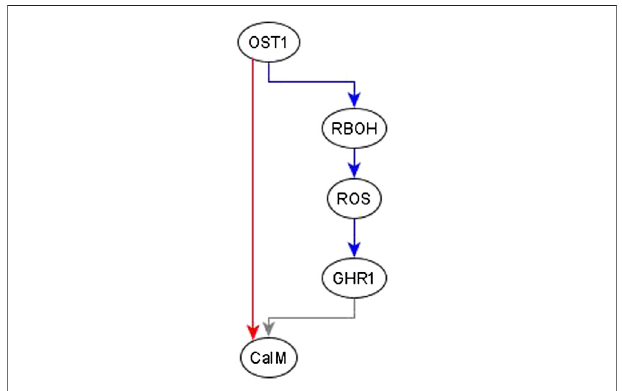
FIGURE 6 | Addition of suf fi cient edge from OST1 to CaIM to re fl ect the causal logic inferred from the literature. The suf fi cient regulatory relationship of OST1andCaIMisnotre fl ectedinthepathgivenbyOST1 → RBOH → ROS → GHR1 → CaIM.Thepath fromOST1toGHR1 isnecessarybut theedge fromGHR1toCaIMisneithersuf fi cientnornecessarysincetheruleforCaIMis CaIM* = Actin Reorganization or (NtSyp121 and GHR1 and MRP5) or not ABH1 or not ERA1 or OST1. Hence, the total path from OST1 to CaIM does nothaveanylogicimplication.Thesuf fi cientedgefromOST1toCaIMishence added. Edges in red color are suf fi cient, in blue color are necessary, and in gray color are neither suf fi cient nor